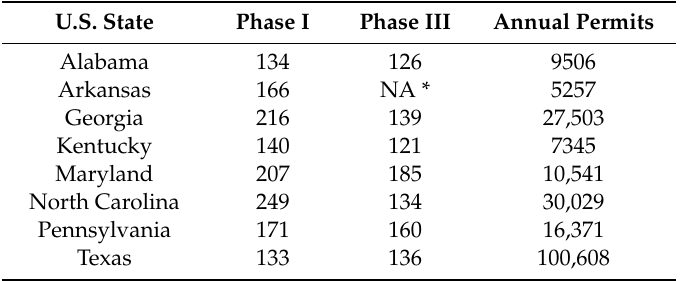
Table 2. Number of Homes Visited and Annual